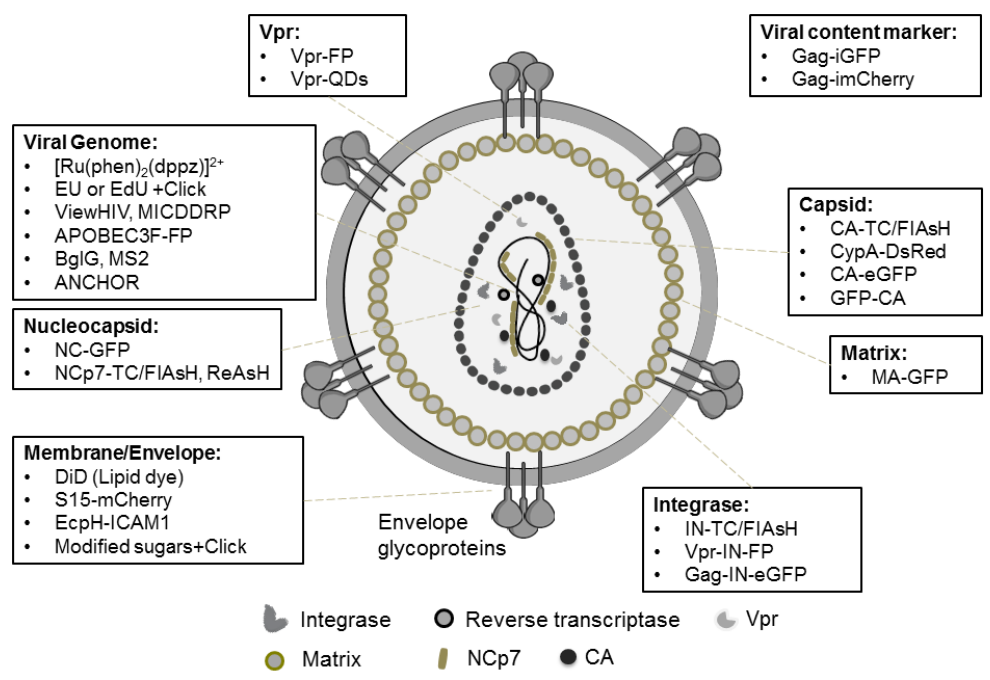
Figure 1. Reported strategies for fluorescent labeling of different Human Immunodeficiency Virus 1 (HIV-1) components (see Table 1 for details). Table 1. Labeling strategies for HIV-1 components.